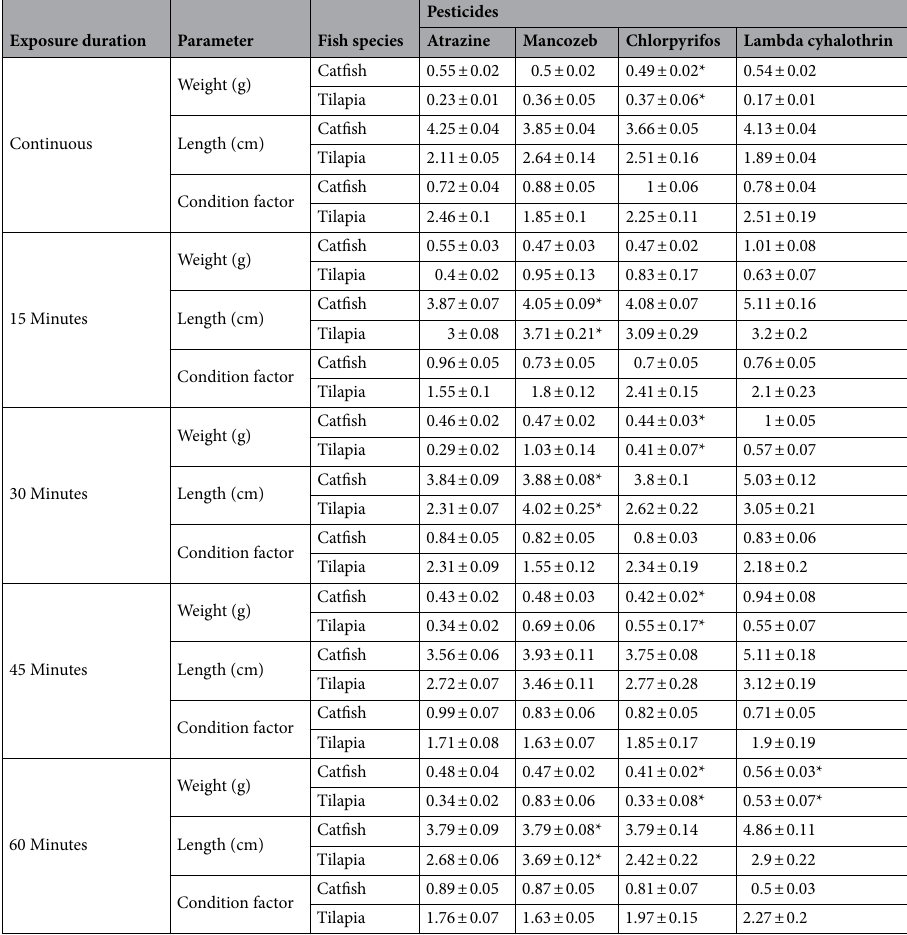
Table 1. Mean values of weight, length and condition factor of fish species. Values indicate mean ± standard error, N = 20. Parameters of catfish was significantly different from Nile tilapia ( p < 0.05), except those marked with asterisk (*) ( p >